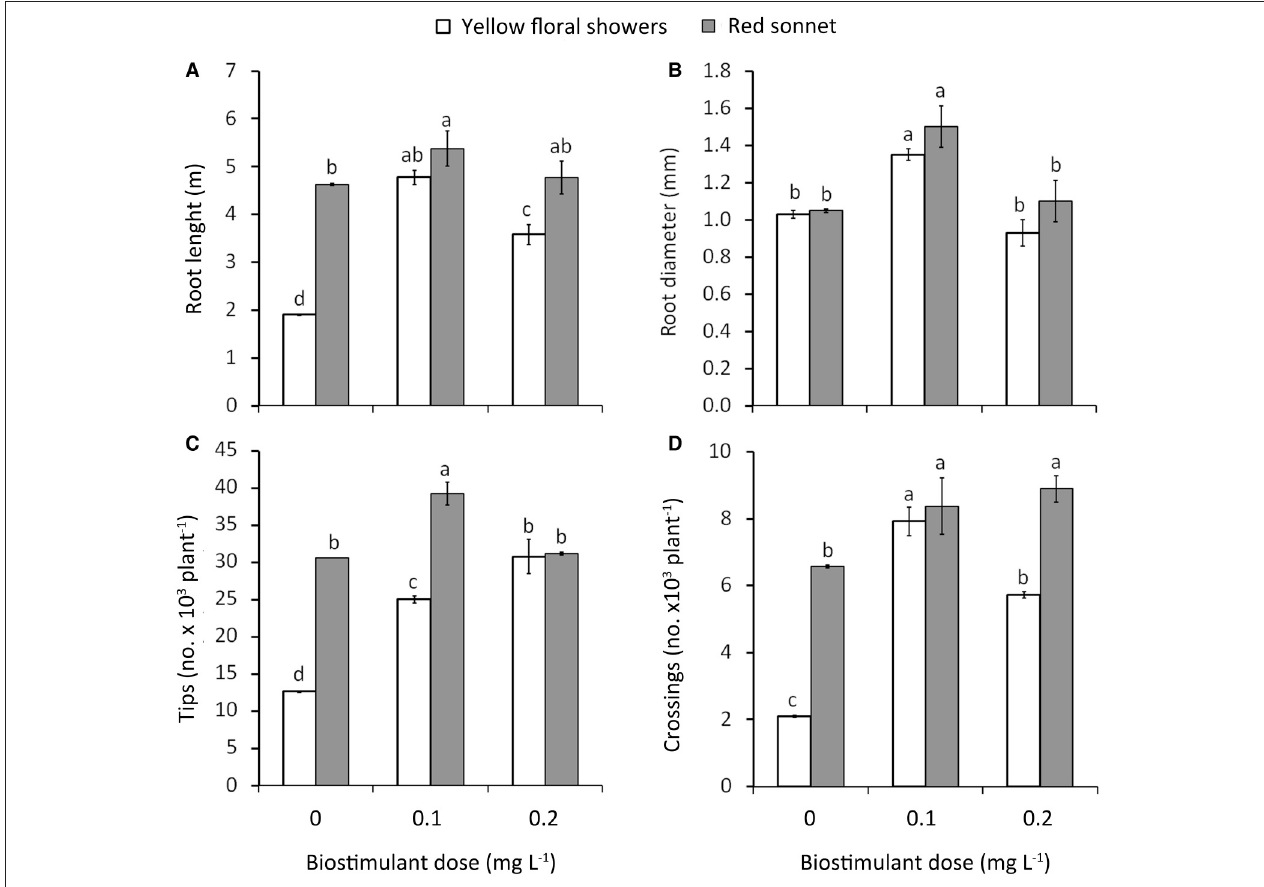
FIGURE 2 | Effect of biostimulant dose (D 0 , D 0.1, and D 0.2 ) and cultivar (“Yellow floral shower” and “Red sonnet”) on root length (A) , root diameter (B) , tip number (C) , and crossing number (D) at the end of the experiment (166 DAT). Vertical bars (standard error) ( n = 6) with different letters are significantly different according to Duncan’s test ( P =